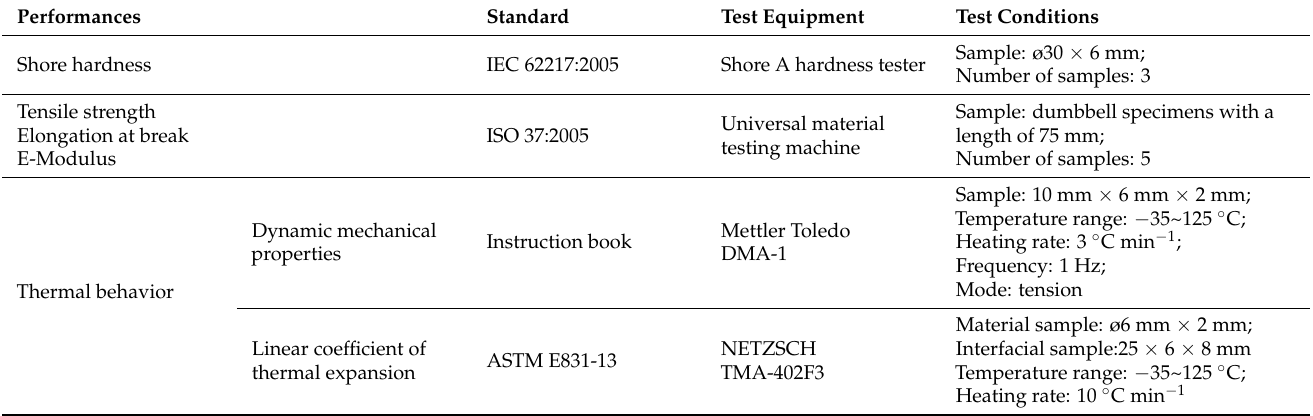
Table 1. Samples for the physical property tests, standards, test conditions and test